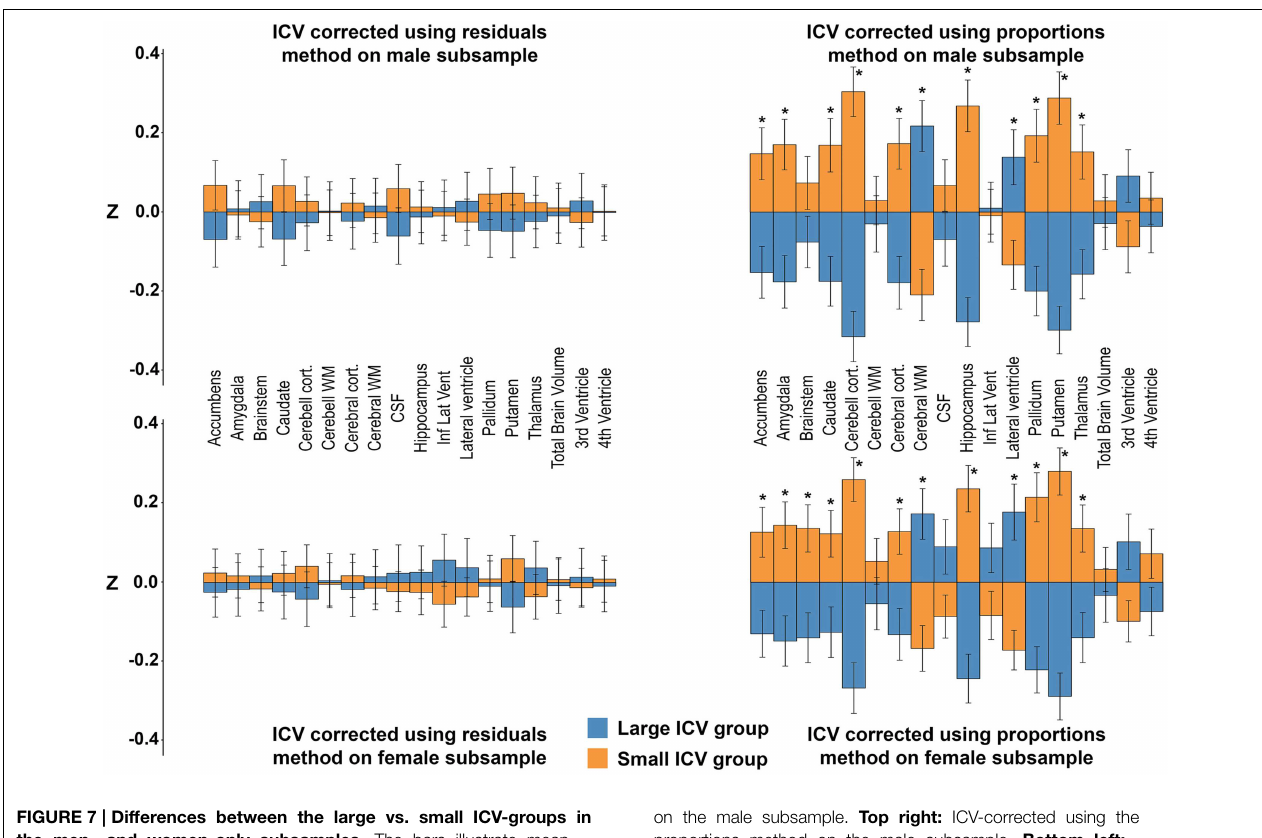
FIGURE 7 | Differences between the large vs. small ICV-groups in the men- and women-only subsamples. The bars illustrate mean standardized volume for the large-ICV groups (blue) and small-ICV groups (orange) with the standard error superimposed. Y-axis: Z-score of the residuals. Top left: ICV-corrected using the residuals method